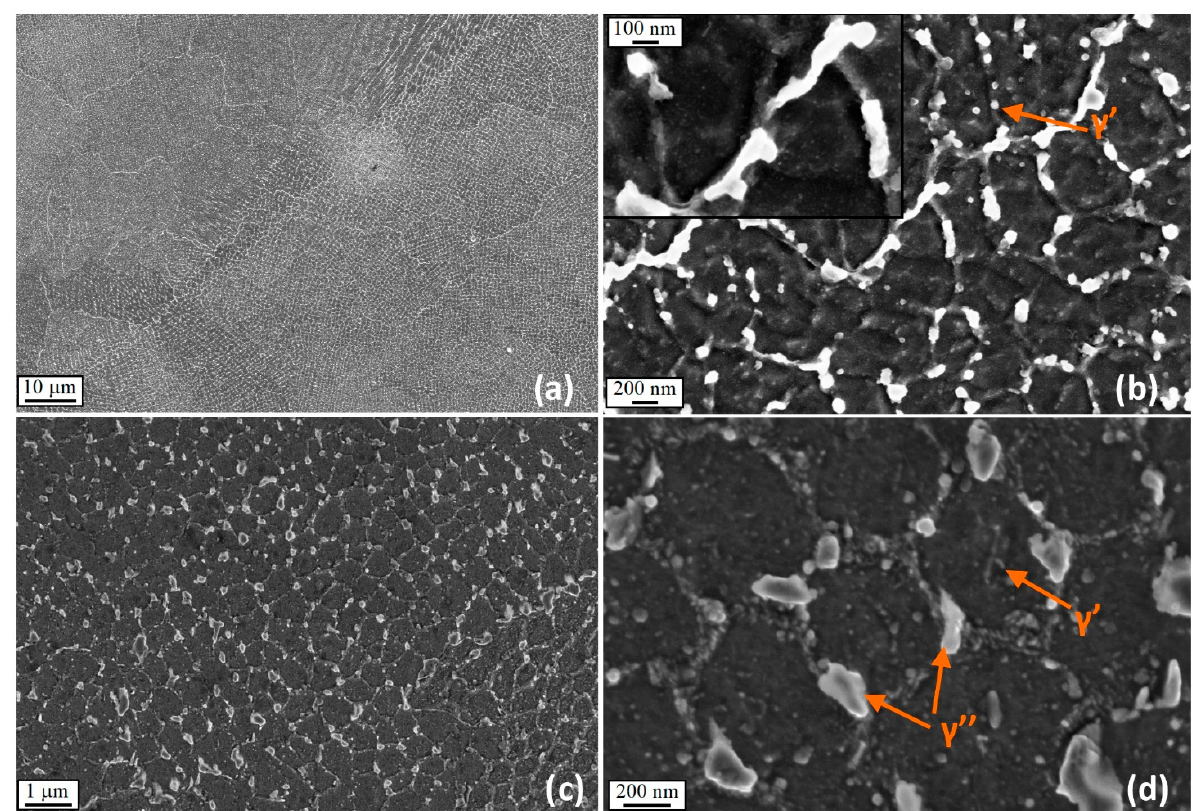
Figure 5. IN718 observed under a secondary electrons (SE) detector after direct aging at 650 °C for 8 h ( a ) and ( b ) and after direct aging at 720 °C for 8 h ( c ) and ( d ).